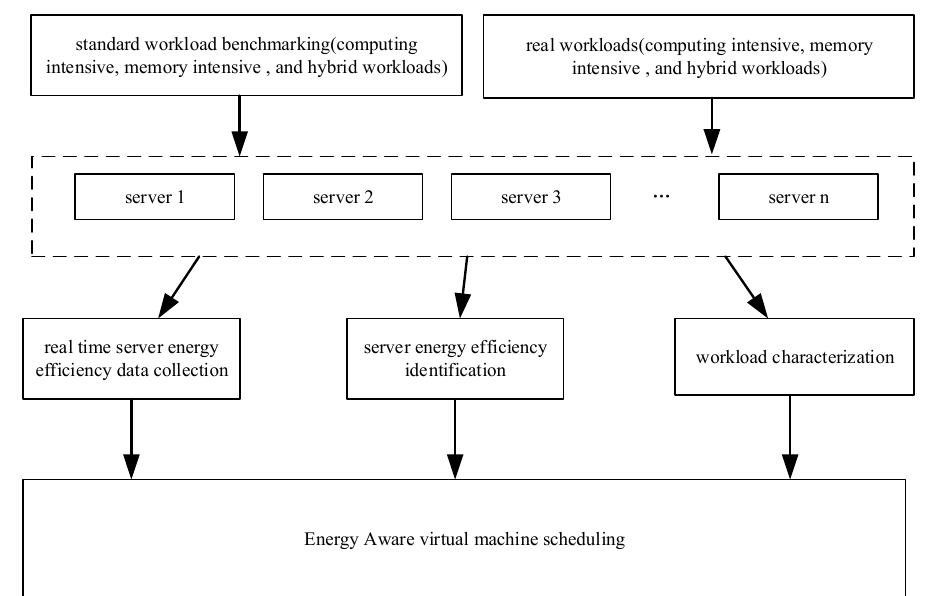
Figure 9. Flow chart of energy aware virtual machine scheduling.